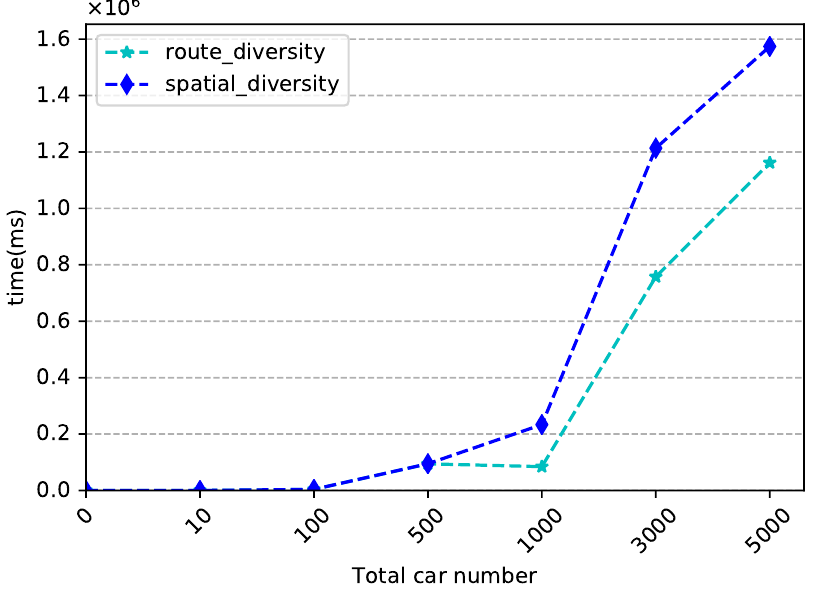
Figure 8. Comparison of accuracy of different